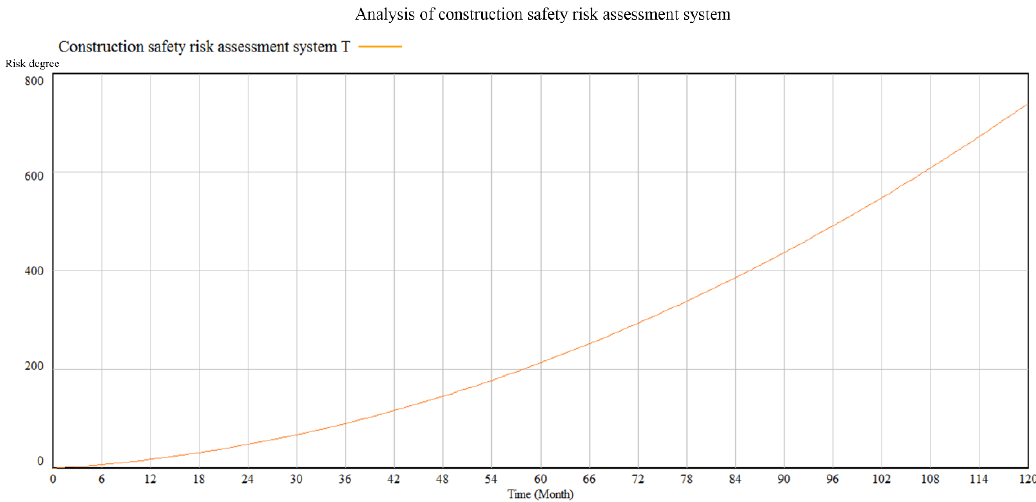
Figure 4. Analysis of construction safety risk assessment system.